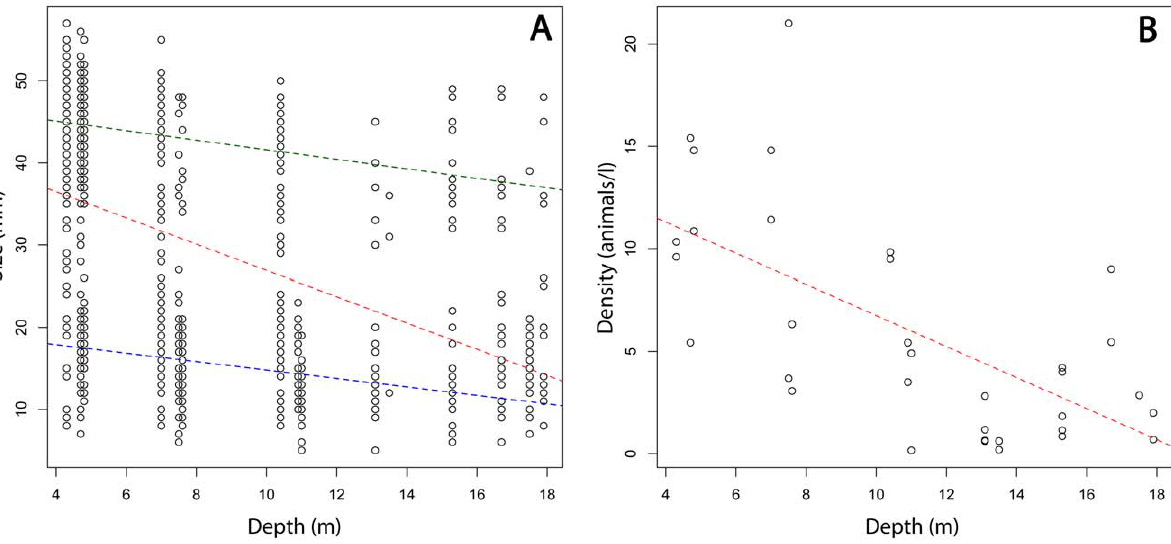
Figure 5. Bivariate linear relationships between amphioxus and depth. A: Linear relationships between amphioxus individual size and depth for juveniles (green line), adults (blue line) and all individuals (red line). B: Linear relationships between individual density and depth for all stations.